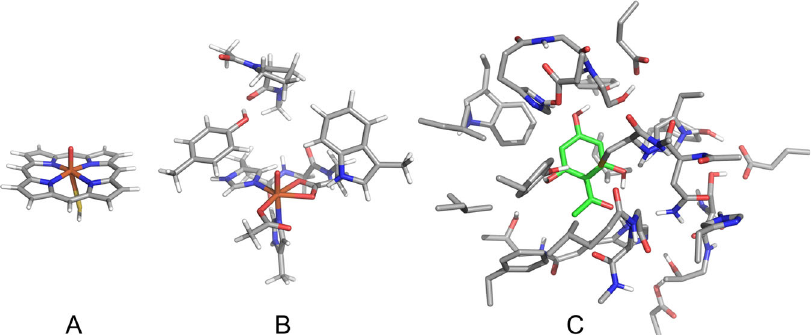
Fig. 2 Examples of active site model sizes at different times. A 40 atoms: Cytochrome P450 in 2000 7 . B 116 atoms: Prolyl-4-hydroxylase in 2010 8 . C 413 atoms: Acyltransferase in 2020 9